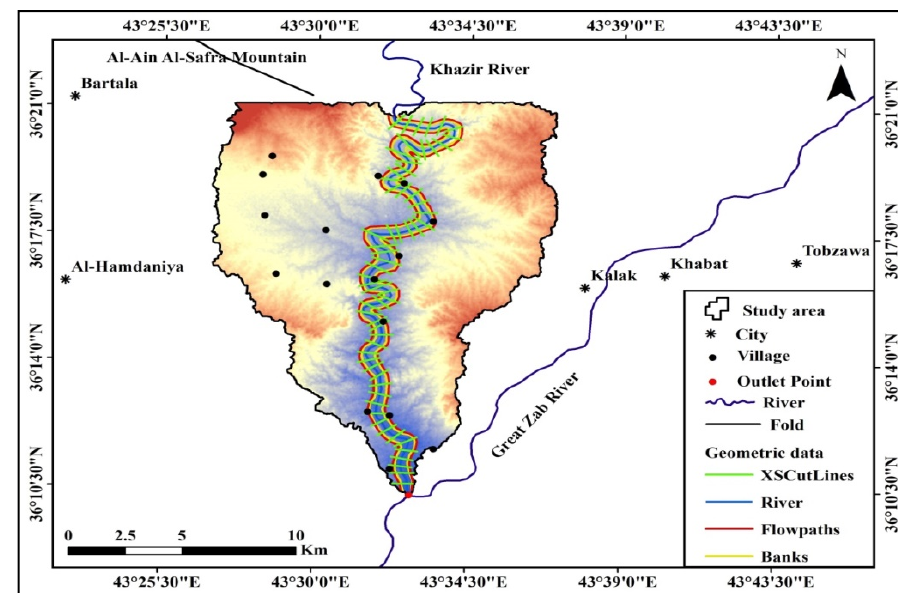
Figure 3. Geometric data of Khazir River.